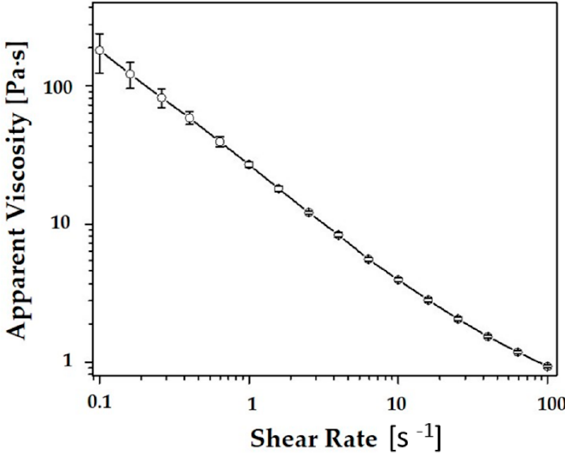
Figure 4. Apparent viscosity of the CaP slurry as a function of shear rate ( ϕ = 45 vol%).